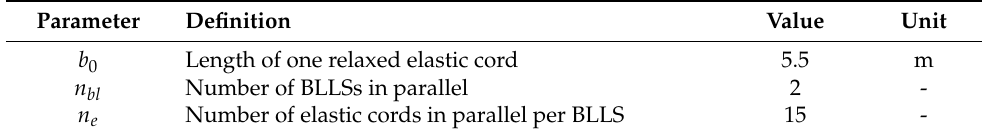
Table 7. The characteristics of the deceleration BLLS.